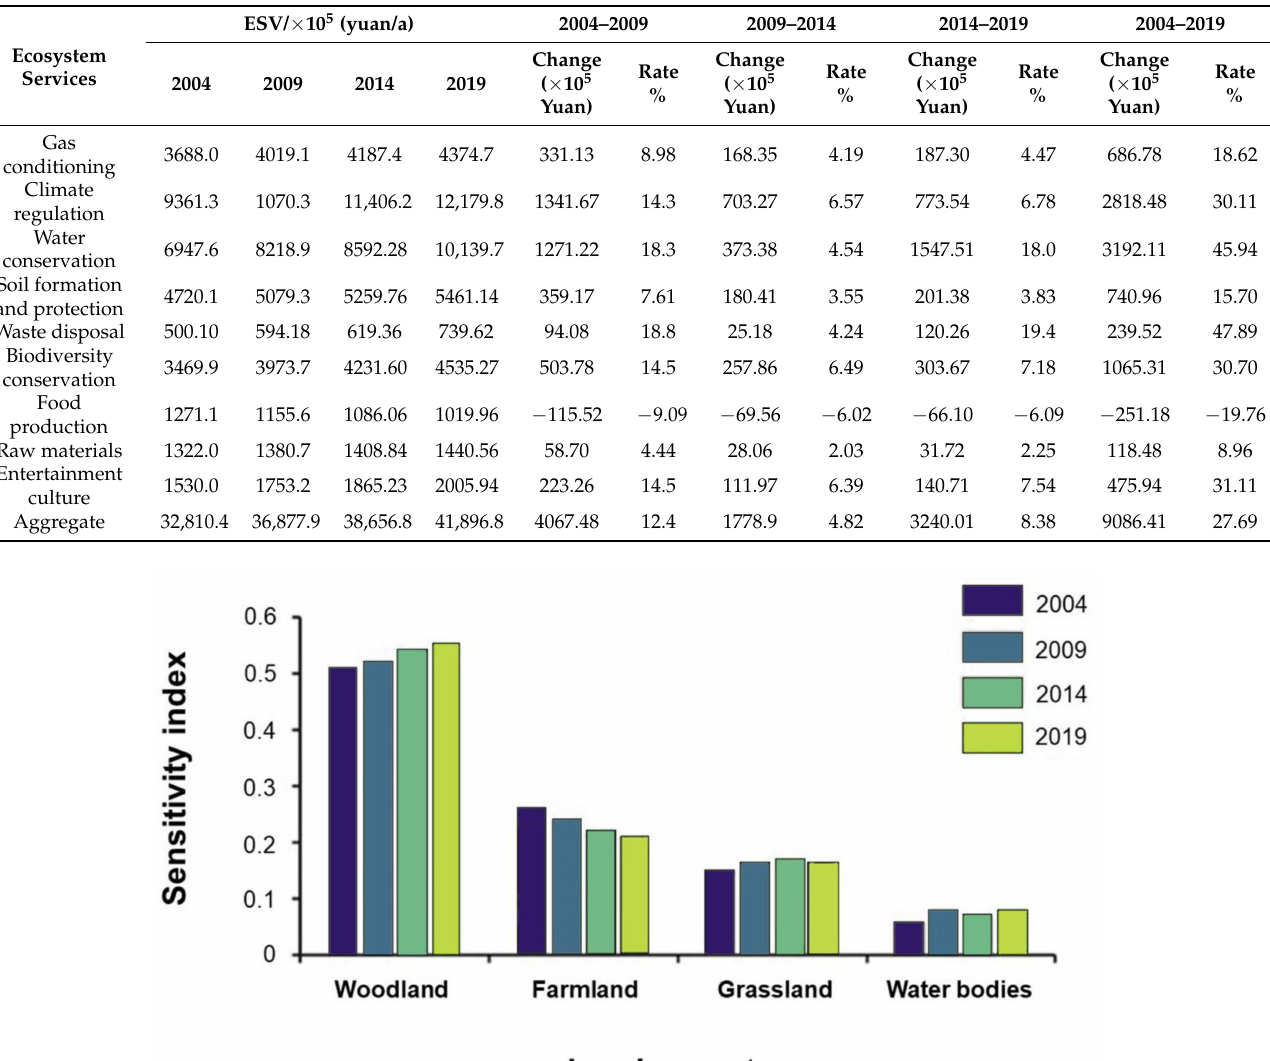
Table 10. Changes in the ecosystem service value (ESV) during the 15 years of study period (2004–2019) in Long County, Shaanxi Province, China.